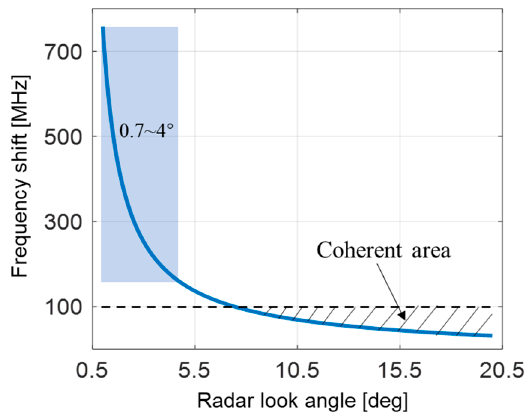
Figure 8. Frequency shift versus radar look angle.